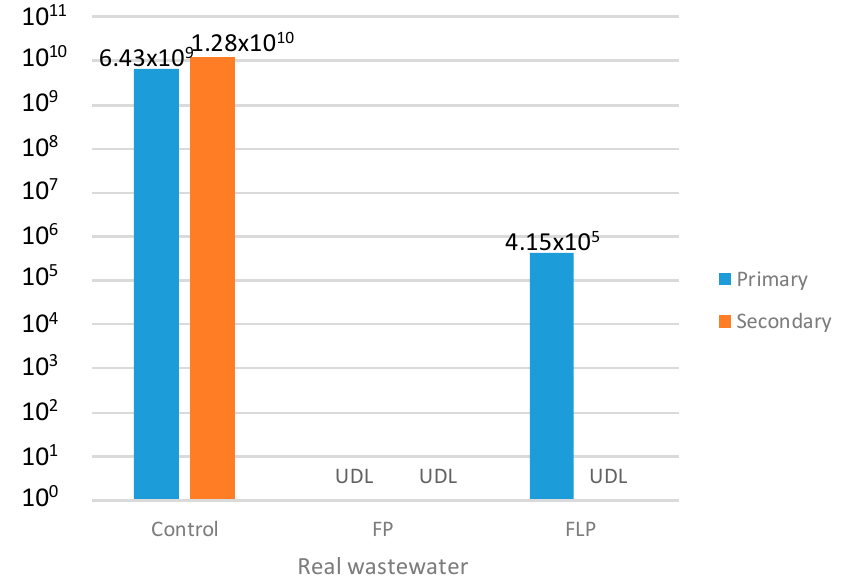
Figure 3. Evaluation of the disinfection in CFU/mL with the optimized conditions on both systems FLP and FP (UDL: under detection limit).